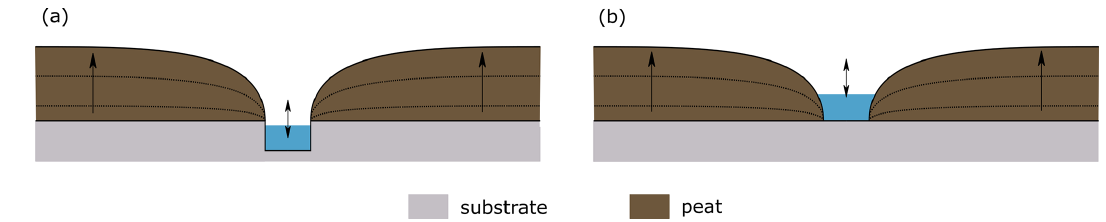
Figure 8. Sketch of the two conceptual channel models used for the long-term peatland development simulations. (a) Rectangular channel, situated within the substrate, with the top of the channel corresponding to the base of the peat. (b) The channel located on top of the substrate, with the channel bottom corresponding to the base of the peat. The channel walls consist of the sloping sides of the peat bodies.